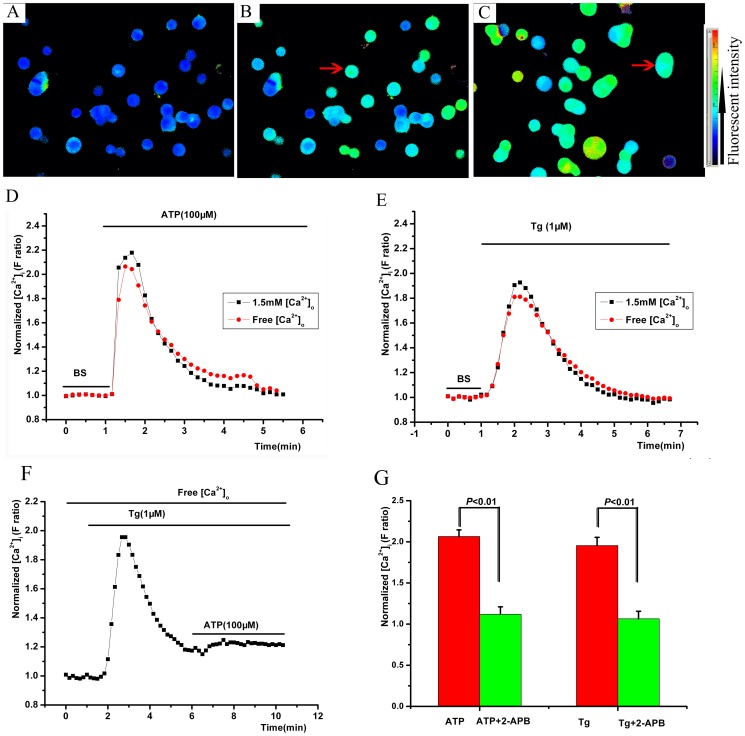
Extracellular ATP induced a [Ca2+]i transient elevation in macrophages.A, representative calcium imaging in control solution. B, calcium imaging with ATP (100 µM), the red arrow showed the peak [Ca2+]i. C, calcium imaging with thapsigargin (Tg, 1 µM), the red arrow showed the peak [Ca2+]i. D, time series of the ratio of fluorescence intensity at excitation wavelengths of 340 and 380 nm (F ratio) during the application of ATP. E, time series of the mean F ratio during the application of Tg. F, time series of the mean F ratio during the sequential application of Tg and ATP. G, 2-aminoethoxydiphenyl borate (2-APB, 100 µM) inhibited the [Ca2+]i transient elevation induced by both ATP and Tg. BS, bath solution.